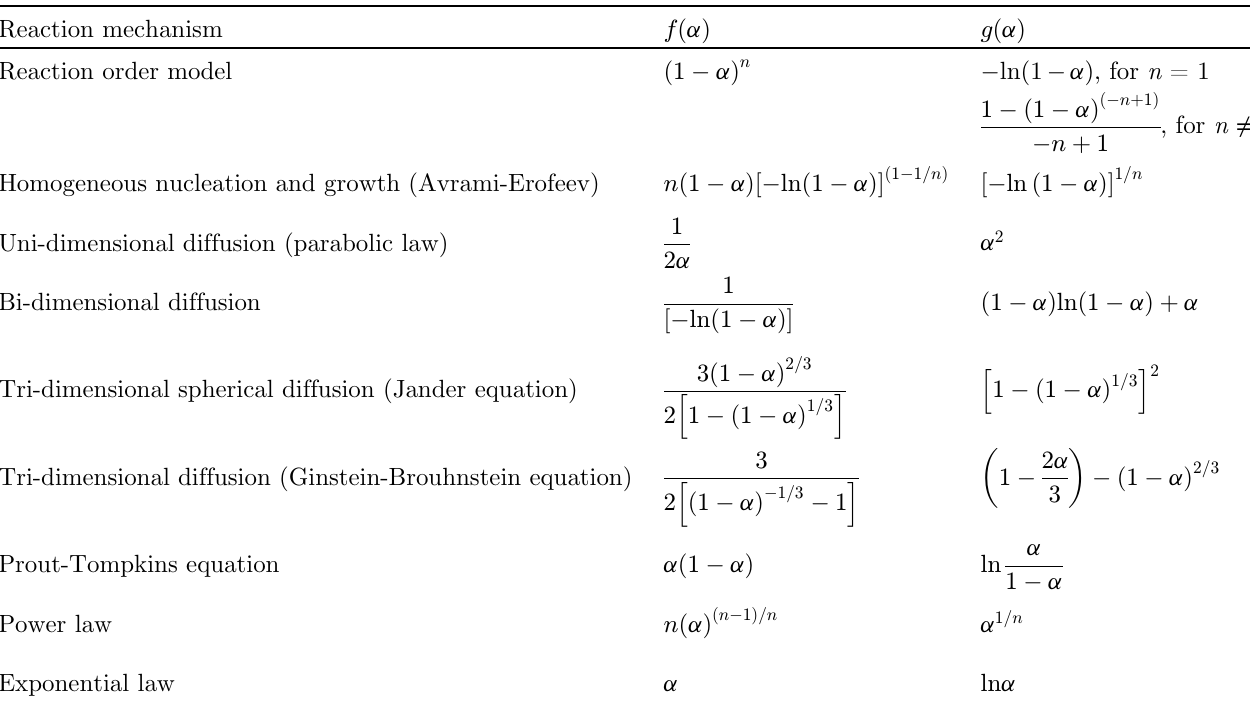
Table 2. The mathematical functions f ( a ) and g ( a ) for the most important solid state reactions mechanisms [9]. Reaction mechanism f a ð Þ g a ð Þ Reaction order